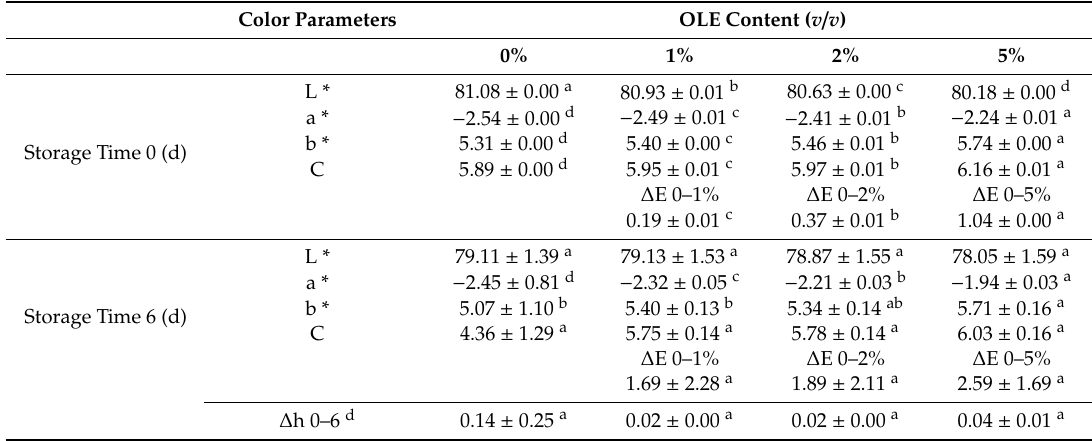
Table 2. Color parameters of milk samples enriched with OLE during